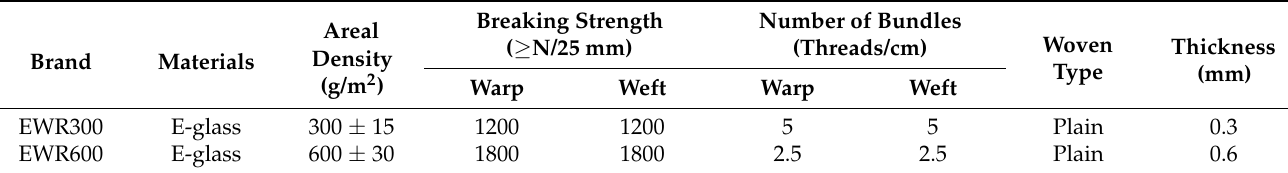
Table 1. Material information of the glass fiber